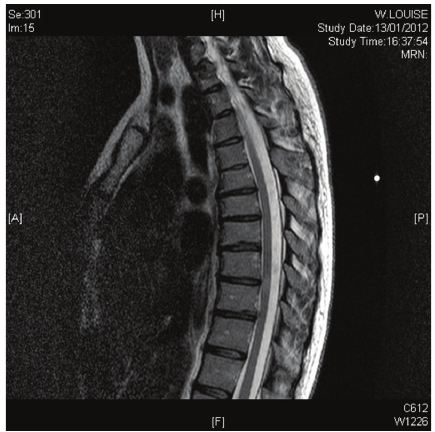
Figure 1: Sagittal view showing increased signal seen at the level of C5 and T8/8, appearances compatible with an inflammatory cause.